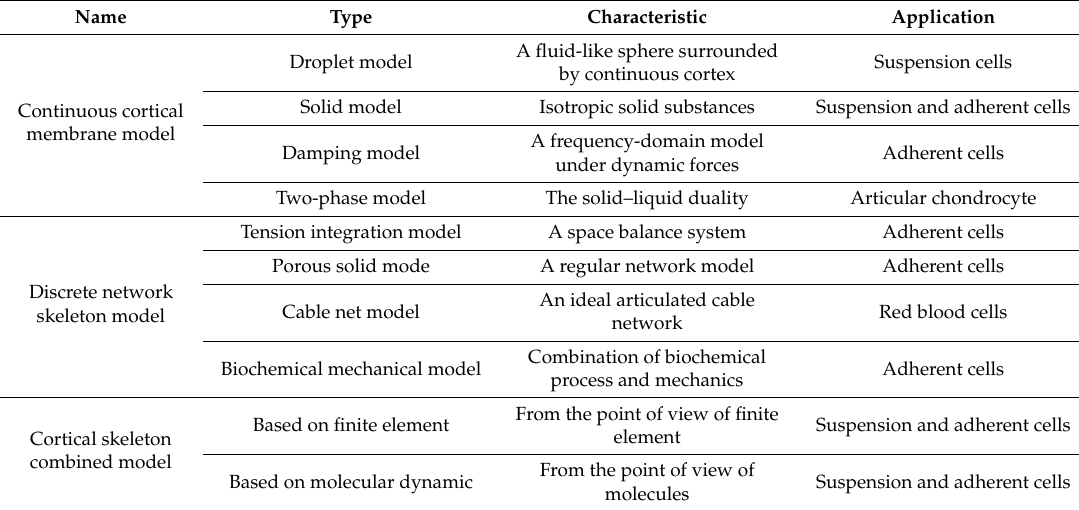
Table 2. The comparisons of cell mechanical